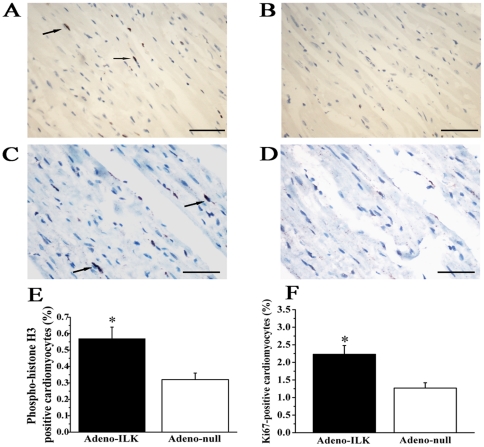
Cardiac ILK gene therapy increases left ventricular cardiomyocyte proliferation in doxorubicin-induced heart failure.A–B, Phosphohistone-H3 staining for mitotic analysis (brown, arrows), in adeno-ILK (A) and adeno-null (B) treated rats. C-D, Ki-67 staining showing more positive cells (brown, arrows) in adeno-ILK tissue sections (C) than in adeno-null sections (D). E–F, Accumulated results showing phosphohistone-H3 (E) or Ki-67 (F) positive cardiomyocytes in adeno-ILK and adeno-null groups. n = 6 per group. *P<0.05 versus adeno-null group. Scale bars: 100 µm.